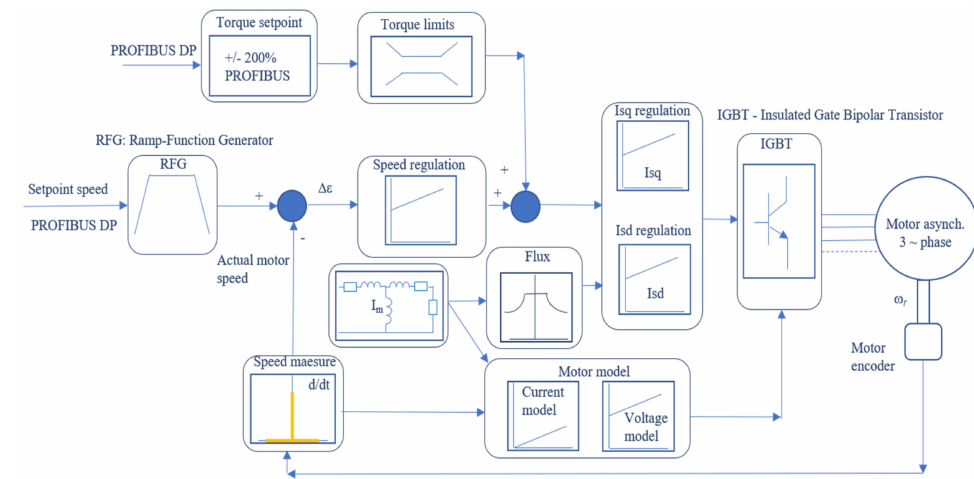
Figure 3. Block diagram of FOC control algorithm, [5,18].